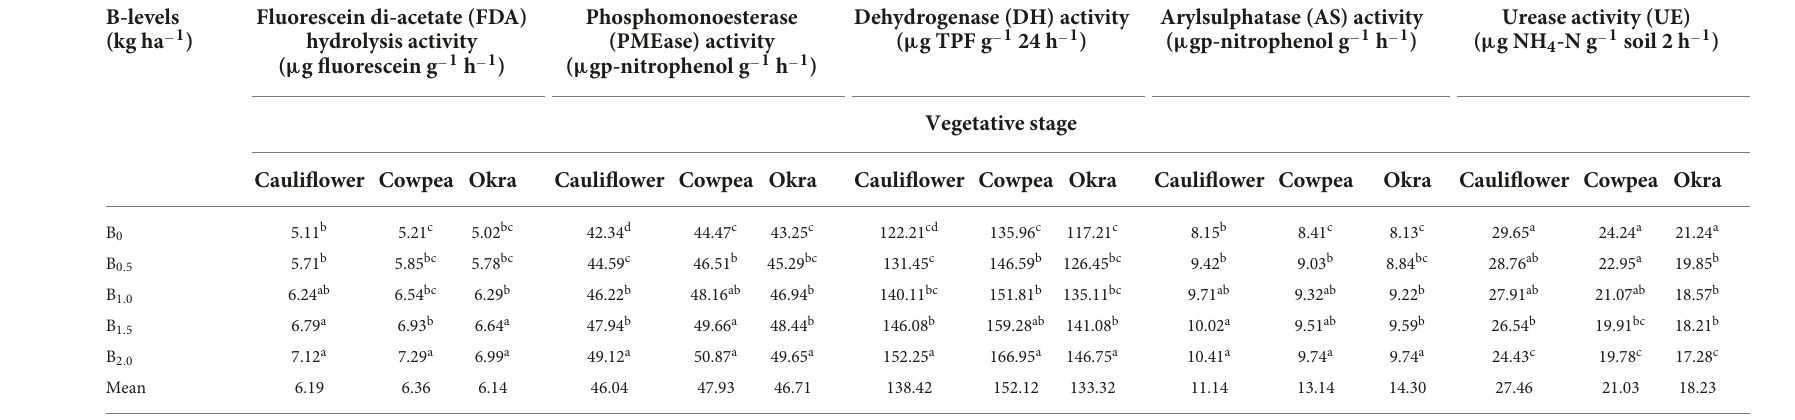
TABLE 5 Effect of graded B levels on soil enzymes in cauliflower-cowpea-okra cropping system (Pooled data 2015–2017). B-levels (kg ha − 1